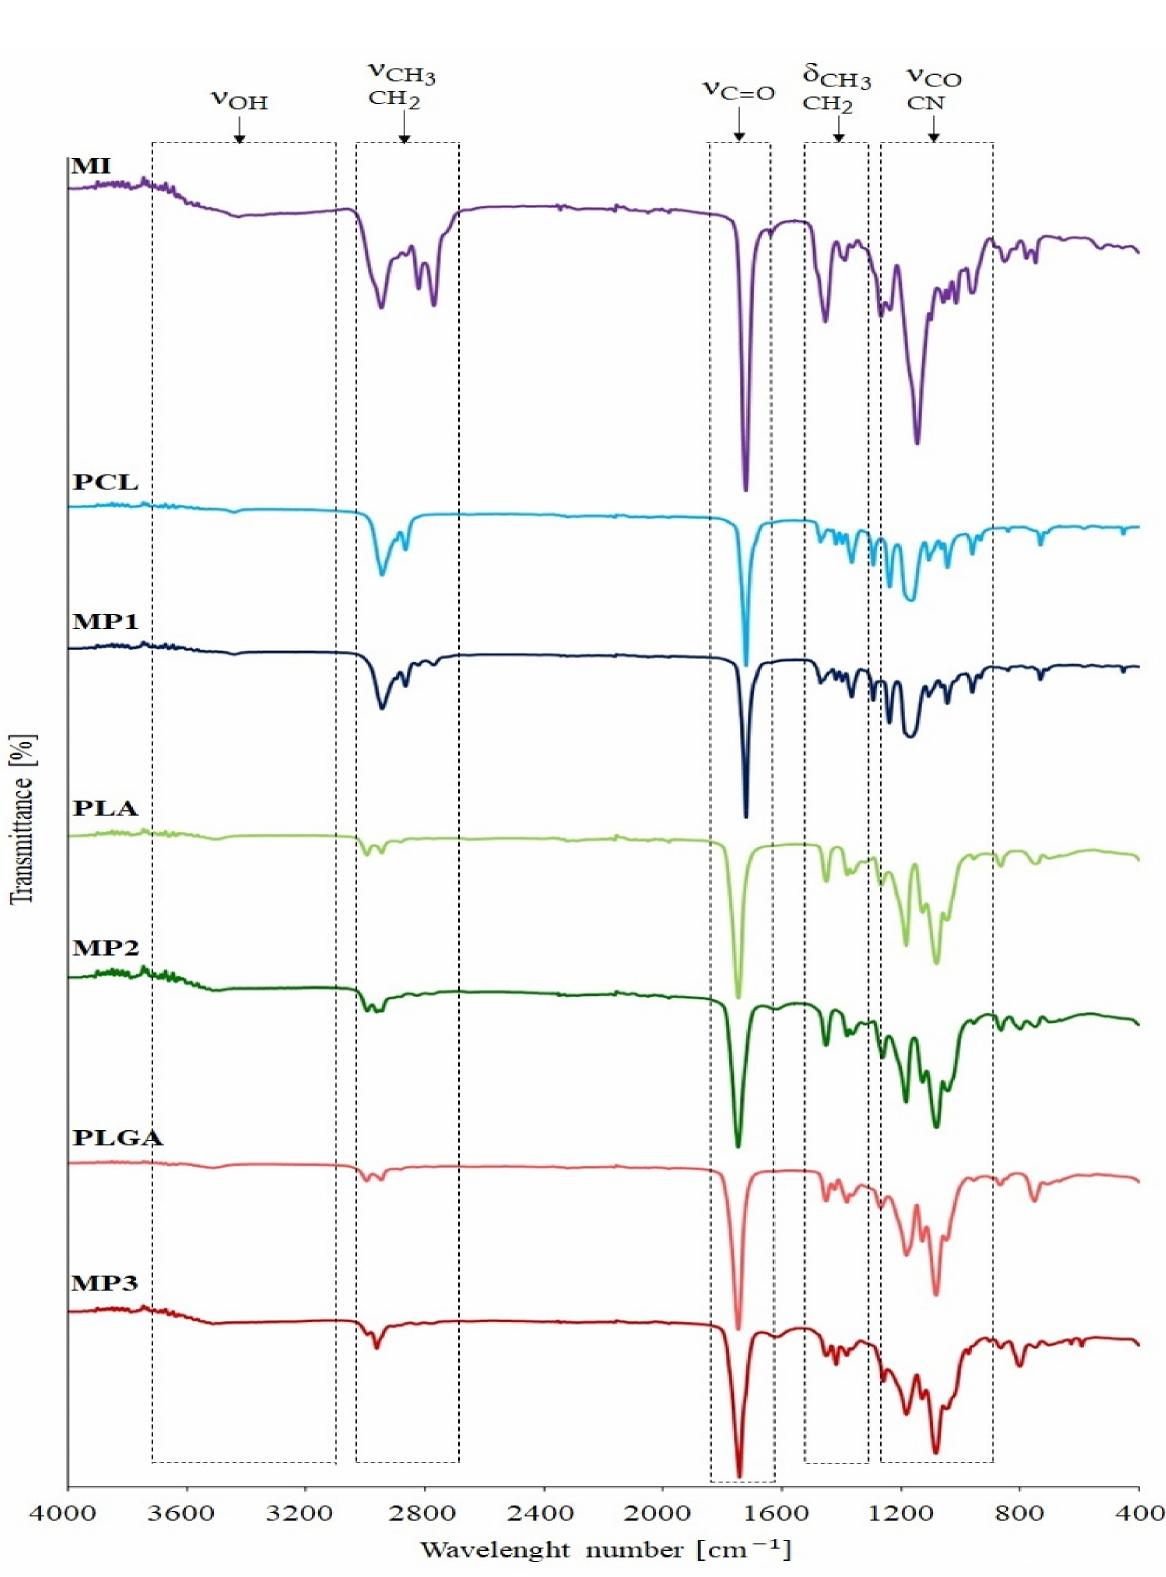
Figure 3. ATR-FTIR spectra of obtained miktopolymers before degradation and pure